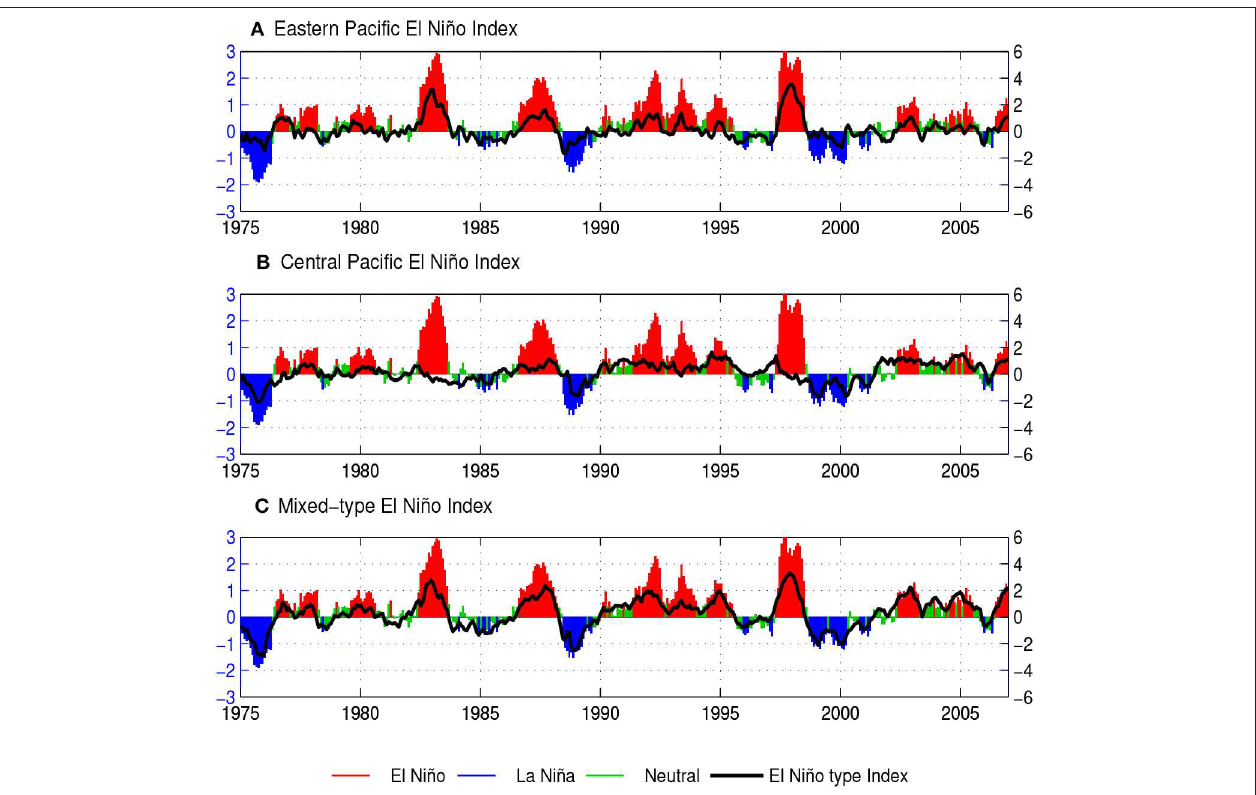
FIGURE 2 | Indices for different types of El Niño in the period 1975-2006: (Left axis) MEI index denoting La Niña (blue), El Niño (red), and Neutral (green) phases of ENSO. (Right axis-black line) Eastern Pacific (EP) type (A) , Central Pacific (CP) type (B) , and Mixed-type (C)